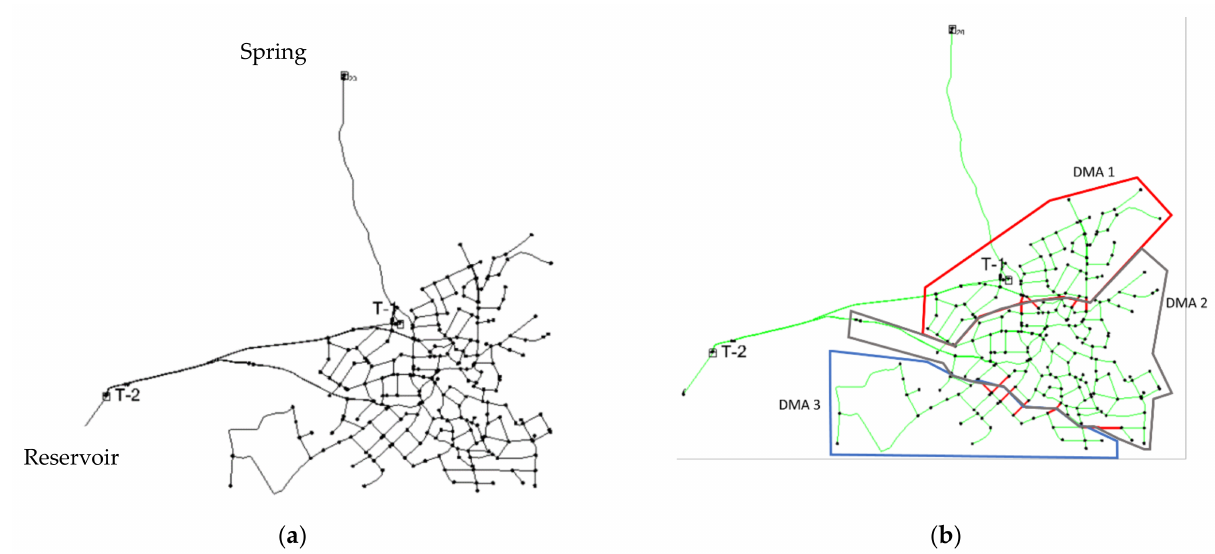
Figure 1. Water distribution network ( a ) no DMAs and ( b ) with three DMAs.